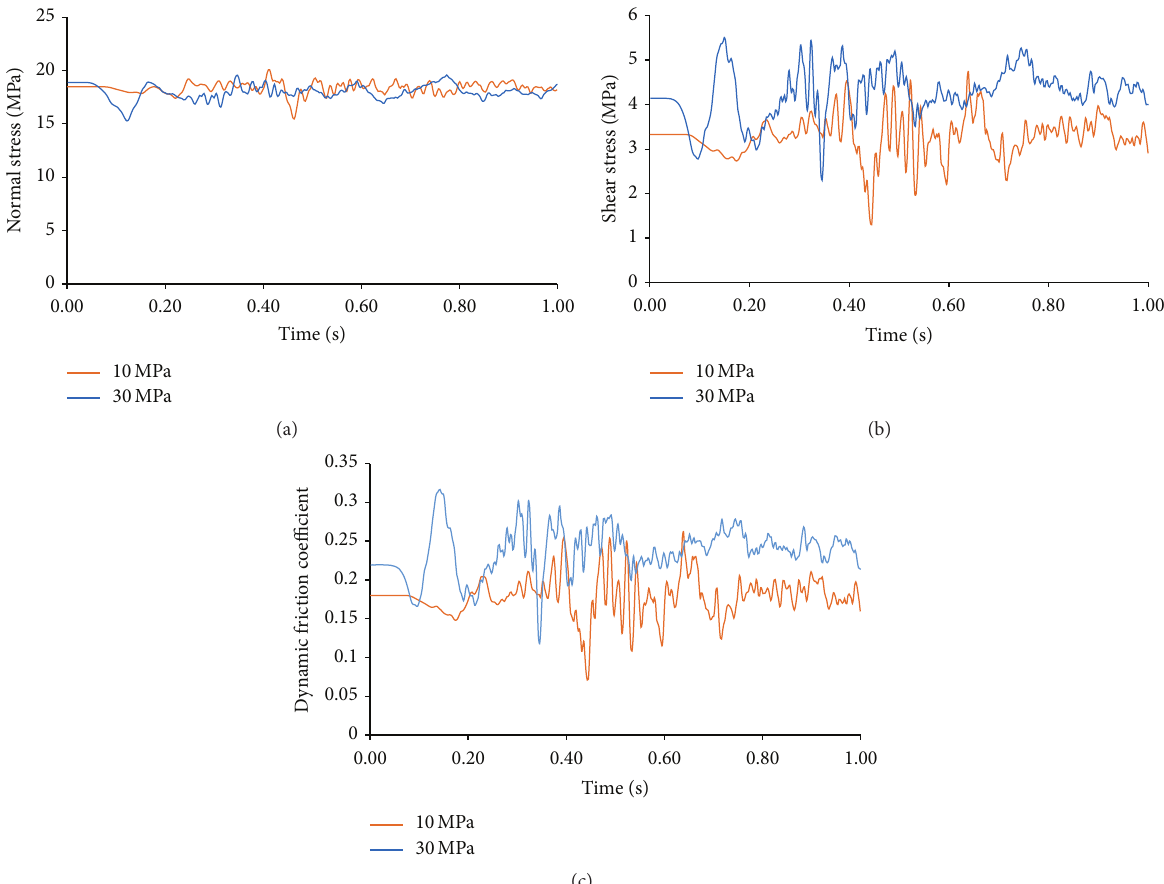
Figure 7: Stress evolution under different stress wave intensity (depth = 500 m). Note that values in the boxes represent the amplitude of the dynamic disturbance ( 𝑝 𝑑𝑚